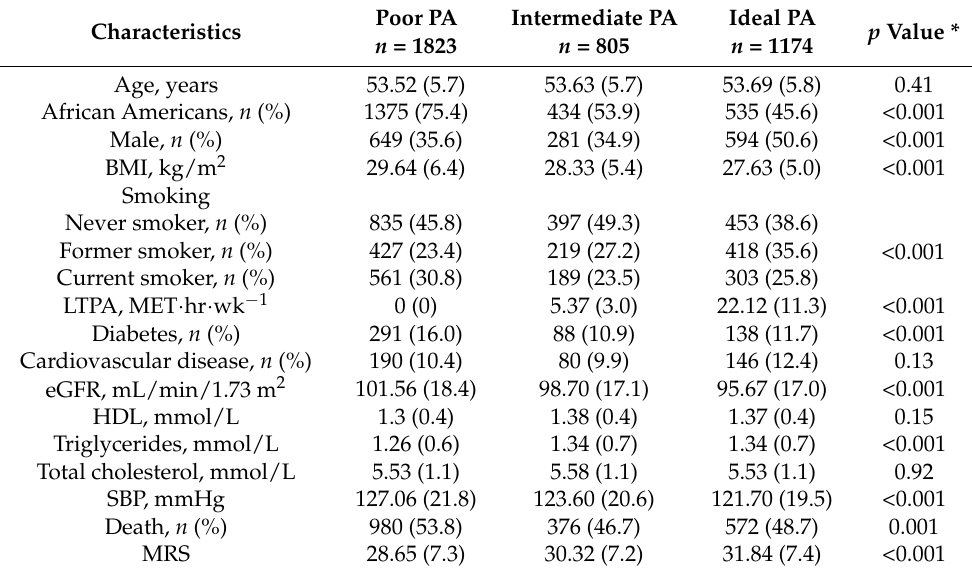
Table 1. Baseline participant characteristics in the Atherosclerosis Risk in Communities (ARIC) study, 1987–1989 ( n = 3802), stratified by physical activity (PA) categories.